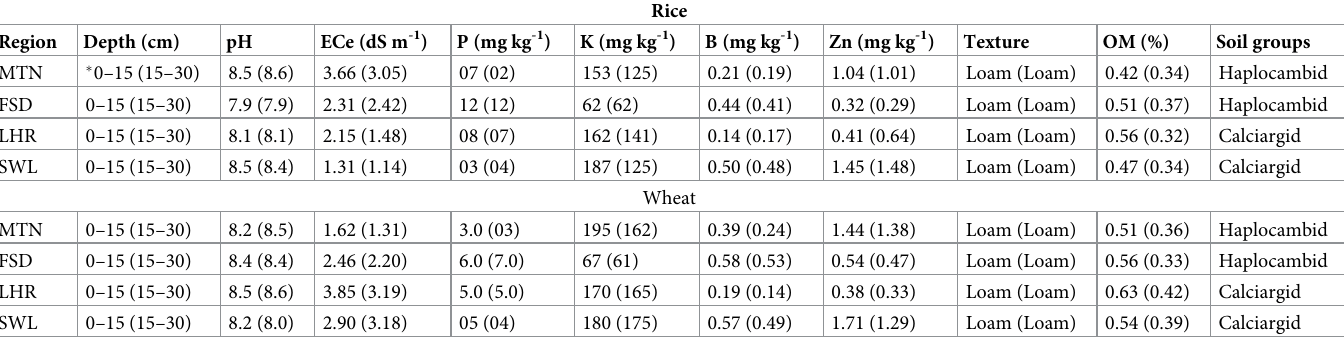
Table 1. Physio chemical properties of pre-sowing soil on different locations.